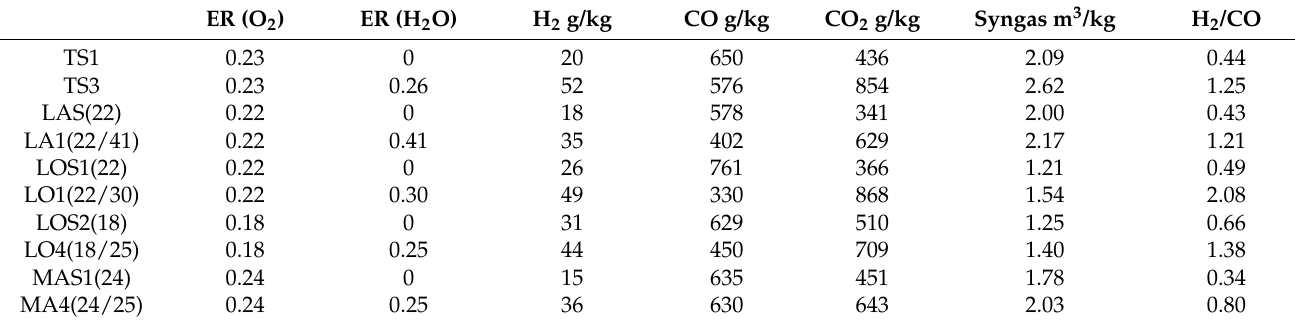
Table 8. Yields of H 2 , CO and CO 2 per kg of dry feedstock as function of the equivalence ratio ER(H 2 O).